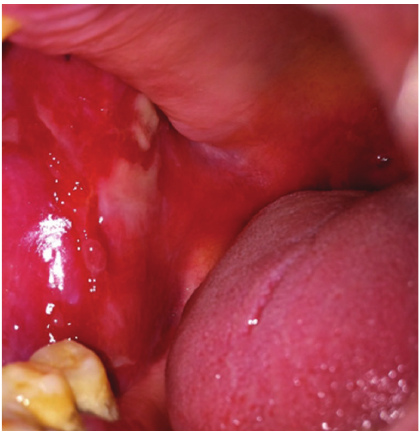
Figure 1: At presentation multiple painful erosions and pseudomembrane-covered erosions on the right buccal mucosa were seen.